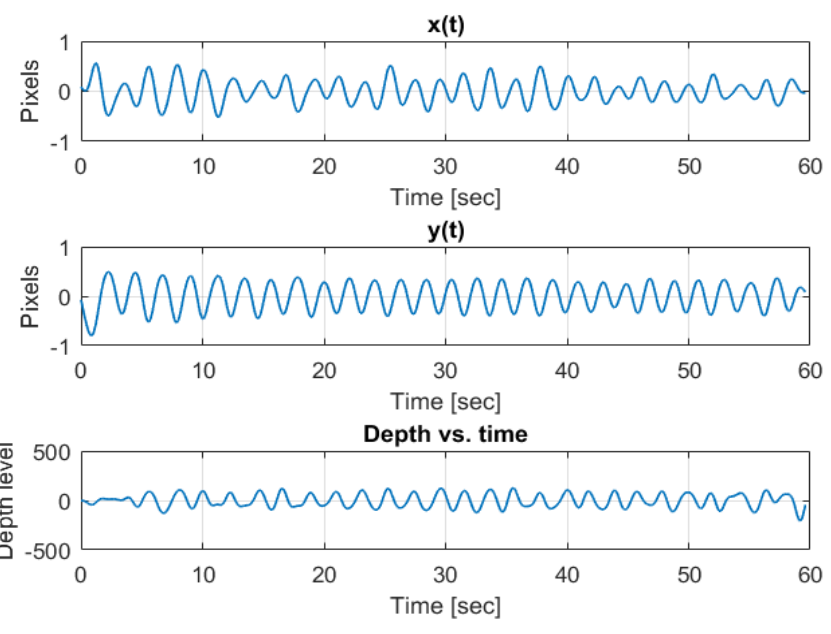
Figure 4. Post band-pass filtering example of three axes (x, y, depth) breathing